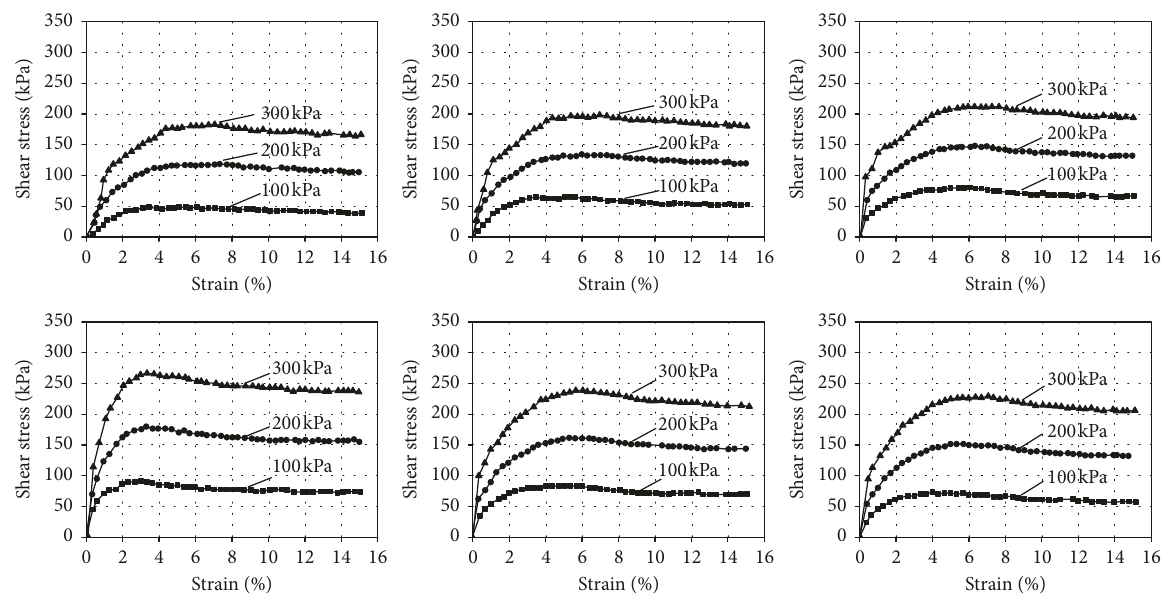
Figure 4: Shear stress-strain curves of fly ash-soil mixture specimens with different fly ash